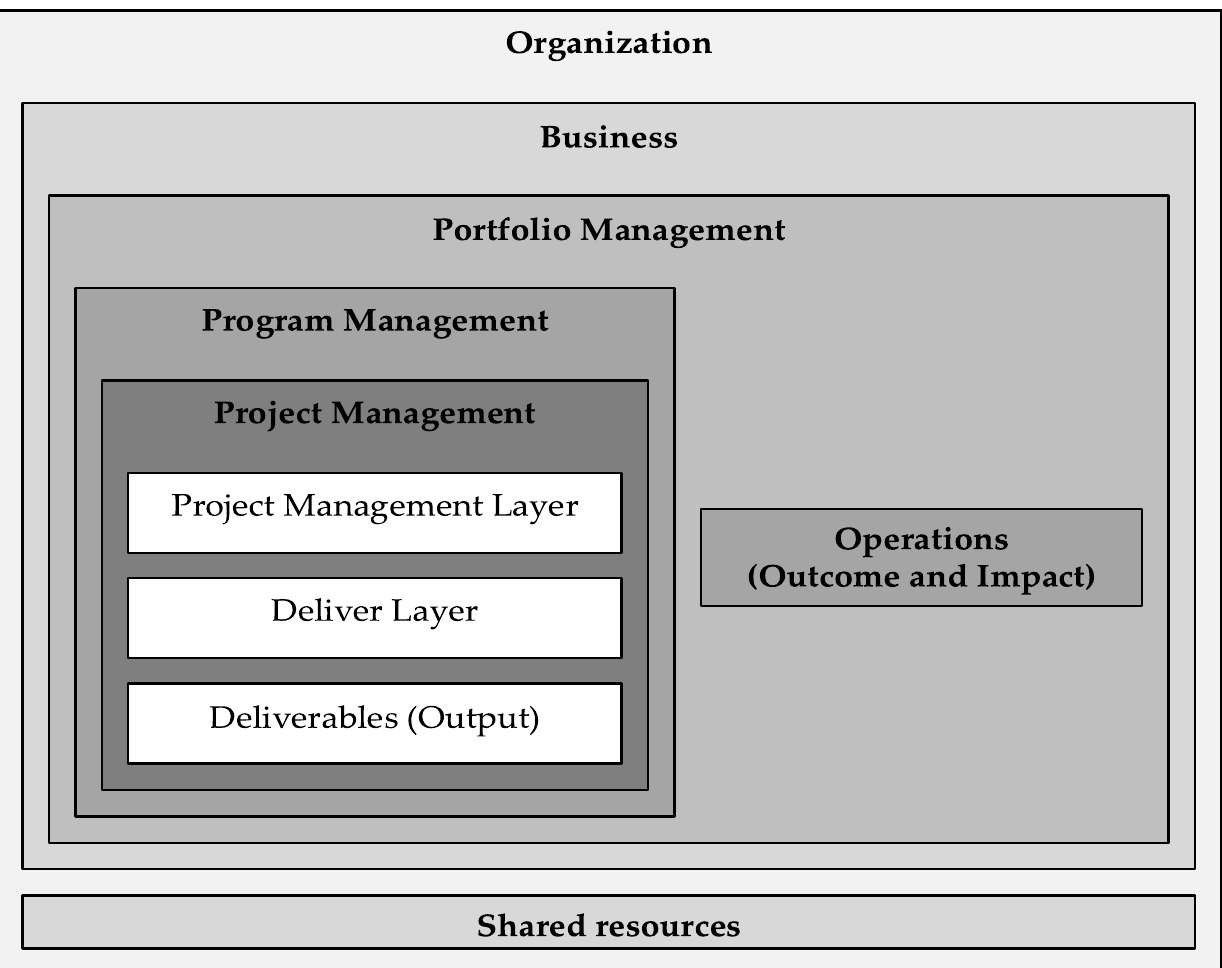
Figure 2. Project Success Levels.